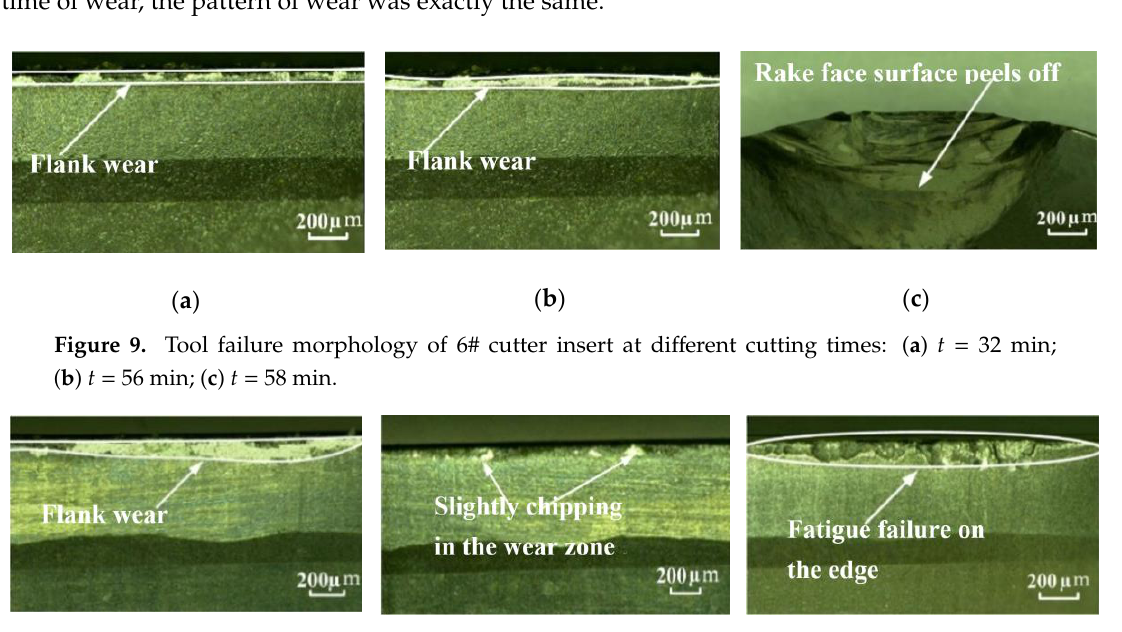
Figure 10. Tool failure morphology of 7# cutter insert at different cutting times fatigue failure: ( a ) t = 18 min; ( b ) t = 68 min; ( c ) t = 84 min.